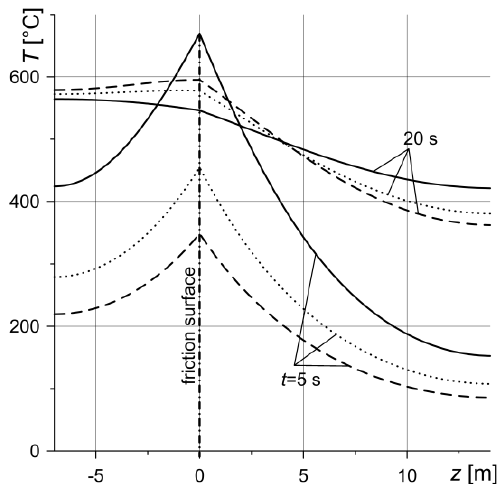
Figure 7. Temperature distributions T in axial direction z on the equivalent radius r = r eq in two time moments t = 5 and 20 s. Solid line—variant 1, dashed line—variant 2, dotted line—variant 3. At a fixed rise time t m = 0.5 s of contact pressure to the nominal value p 0 = 0.45 MPa, the three-parameter relationship of the coefficient of friction f (Equation (29)) allows us to obtain a distribution map of f in the orthogonal coordinate system ( p , T max ) at V eq = 17.531 m·s −1 (Figure 8a). The corresponding map of the coordinates ( V eq , T max ) at p = 0.45 MPa is presented in Figure 8b.